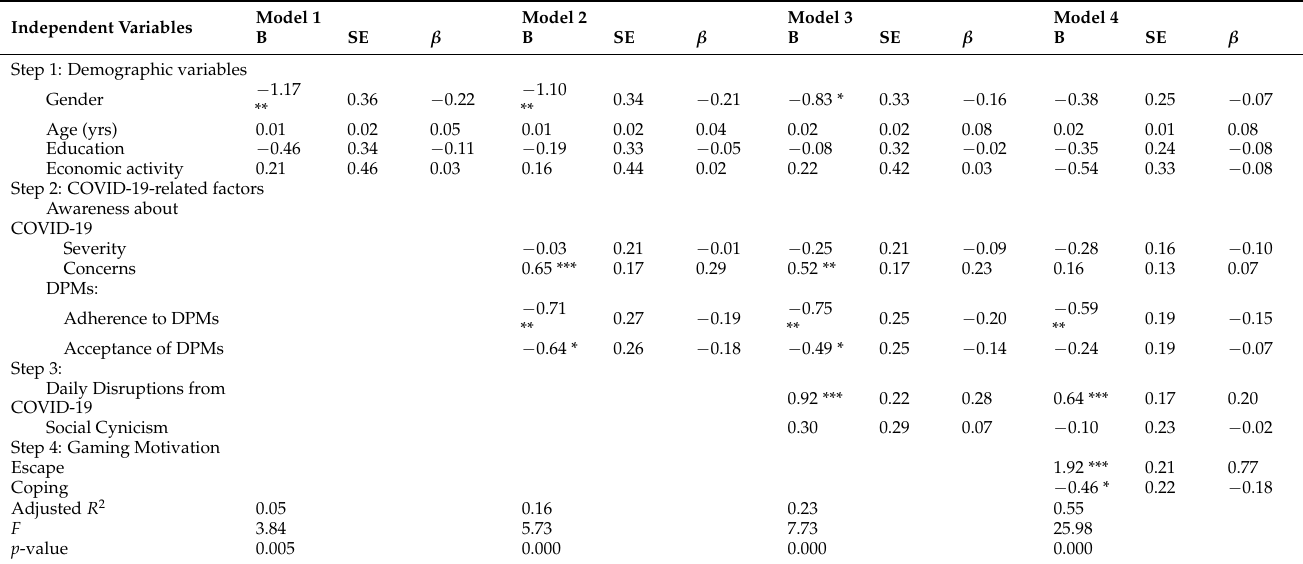
Table 6. Hierarchical Regression Analysis Predicting Internet Gaming Disorder ( N = 203).